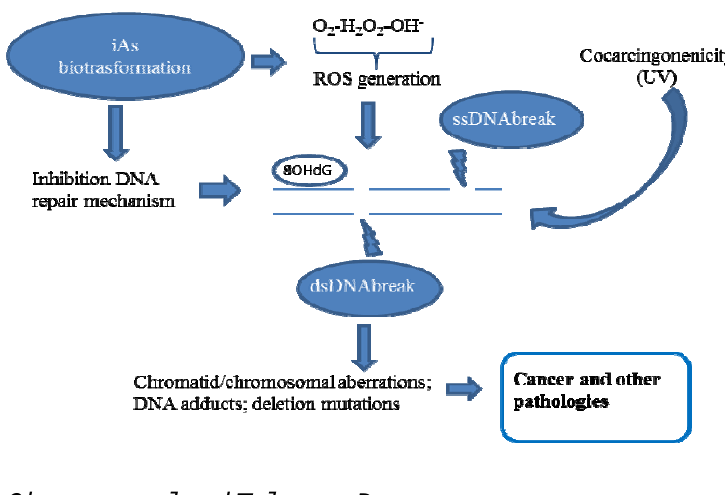
Figure 2. Schematic representation of arsenic